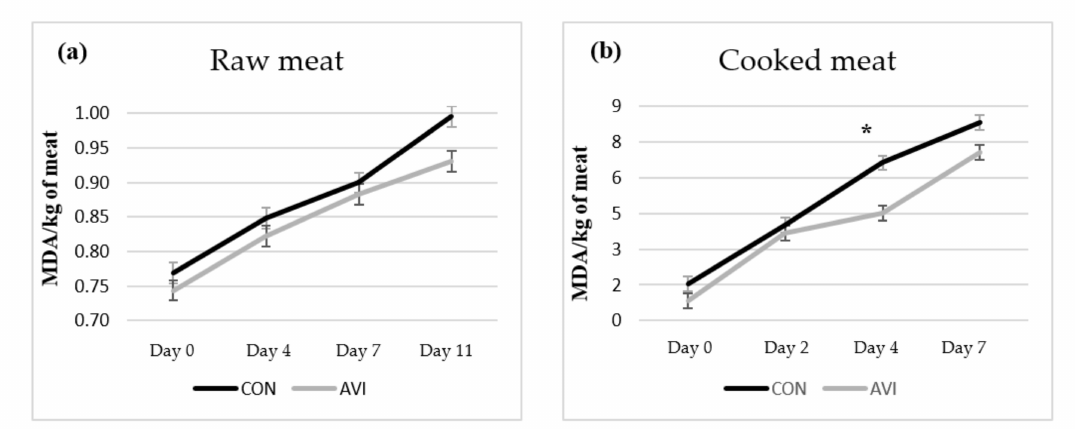
Figure 2. E ff ect of dietary treatment (CON, basal diet; AVI, basal diet + 0.5% organic acids and essential oils) on lipid oxidation trend in raw ( a ) and cooked ( b ) meat ( * : p < 0.05). Significant interactions between diet and storage time were found for a*, b* and C* in cooked meat ( p < 0.05; Figure 3). In AVI meat, a* (redness) and b* (yellowness) indices increased between the fourth and seventh days of storage, while they did not show any variation in CON meat. As a consequence, C* chroma showed the same